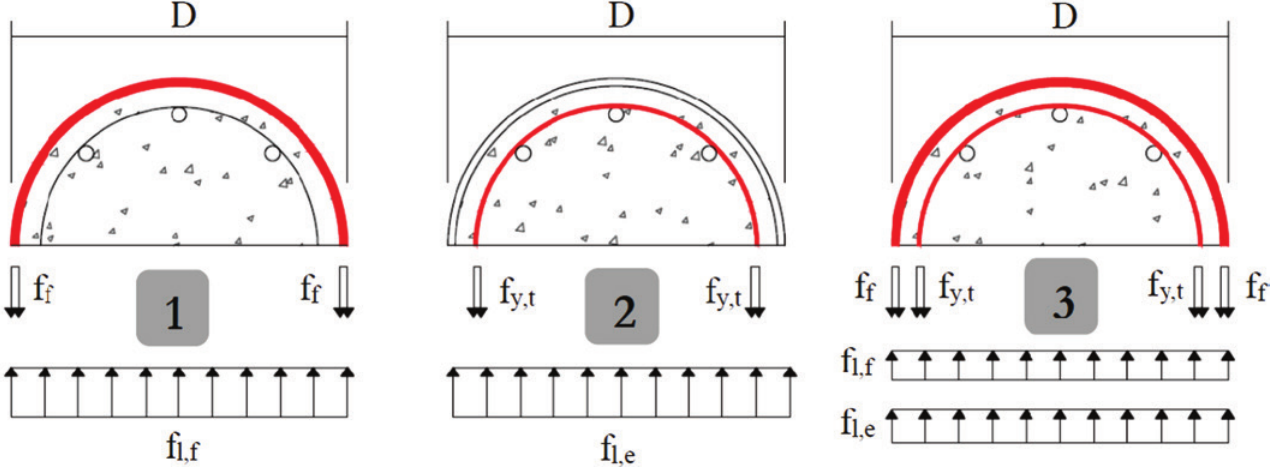
Etapas utilizadas para a análise do confinamento exercido pelo PRF e pela armadura transversal. Etapa 1: Confinamento com PRF; Etapa 2: Confinamento com armadura transversal; Etapa 3: Confinamento com PRF e armadura